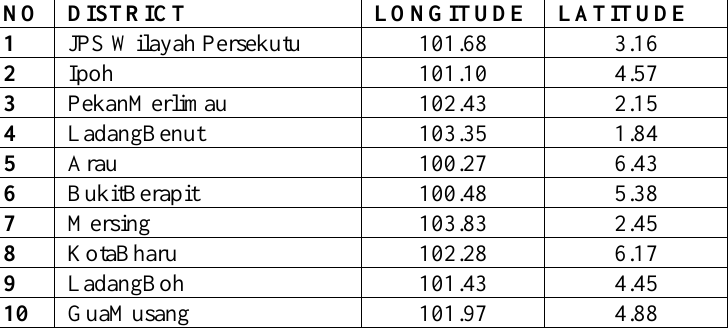
Table 1. Geographical coordinates of the 10 selected rainfall stations in Peninsular Malaysia during the period